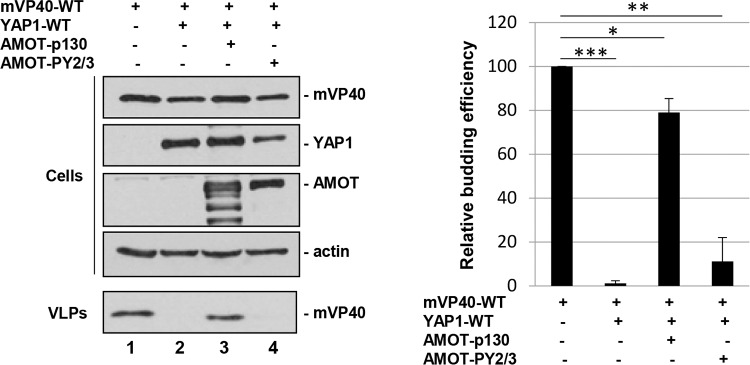
Angiomotin rescue of mVP40 VLP budding is dependent on Amot’s PPxY motifs.HEK293T cells were transfected with the indicated combinations of plasmids (0.25μg of mVP40, 0.25μg of YAP1-WT, 1.0μg of Amot-p130, and 1.0μg of Amot-PY2/3), and both cell extracts and VLPs were harvested at 24 hrs post-transfection. Amot-PY2/3 contains mutations in PPEY motifs #2 and #3 (see Fig 6A). The indicated proteins were detected and quantified in cells and VLPs by Western blotting and NIH Image-J, respectively. Bar graph represents data from at least three independent experiments. * p<0.05, ** p<0.01, *** p<0.001.